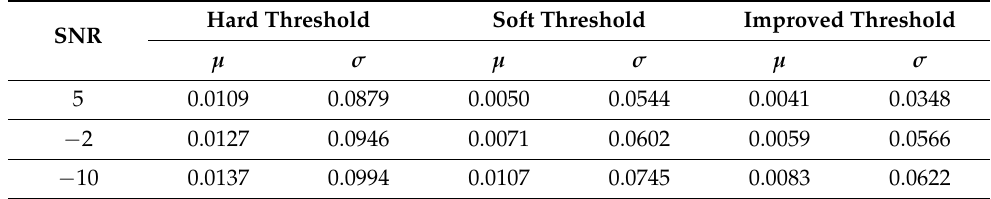
Table 2. Comparison of the denoising effects of hard threshold, soft threshold and improved threshold functions for signals with different